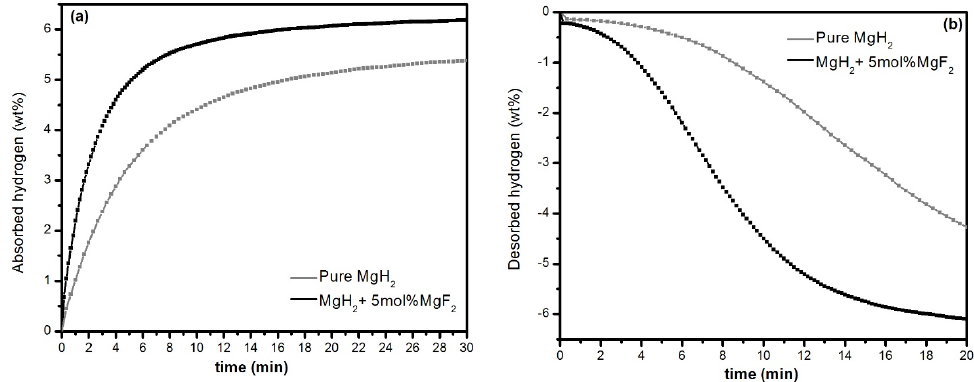
Figure 2. Hydrogen sorption kinetics at 335 °C of 1 h milled MgH 2 without and with 5 mol% MgF 2 . ( a ) First absorption under 1000 kPa H 2 ; ( b ) desorption under 100 kPa H 2 .